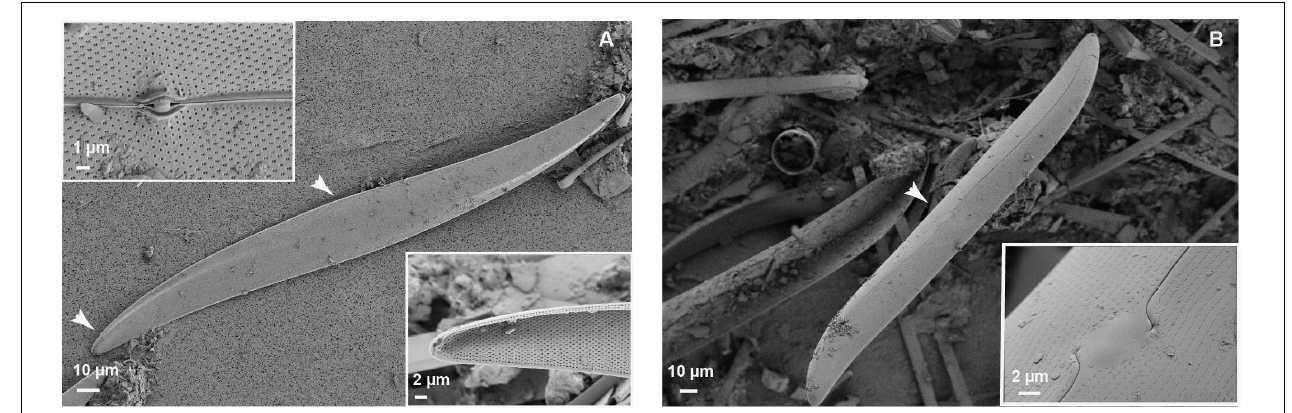
FIGURE 2 | Boxplots of the relative standard deviation (% RSD; A,C,E,G ) and percentage of total detected metabolites (B,D,F,H) comparing the reproducibility associated with three solvent extraction mixtures according to the fraction (CHCl 3 /MeOH) and the technique (GC-MS/LC-MS) used (M1 = MeOH/CHCl 3 (1:1), M2 = H 2 0/MeOH/CHCl 3 (1:1:1), and M3 = H 2 0/MeOH/CHCl 3 (1.5:3.5:5). Statistical analyses were performed using Kruskal–Wallis followed by post hoc Conover’s test. Letters indicate distinct groupings based on post hoc pairwise comparisons among solvent mixtures ( p < 0.05).